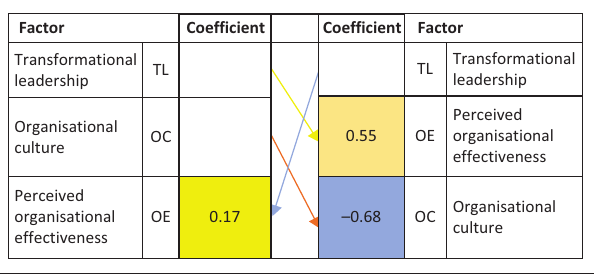
TABLE 7: Path analysis between transformational leadership, perceived organisational effectiveness and organisational culture. Factor